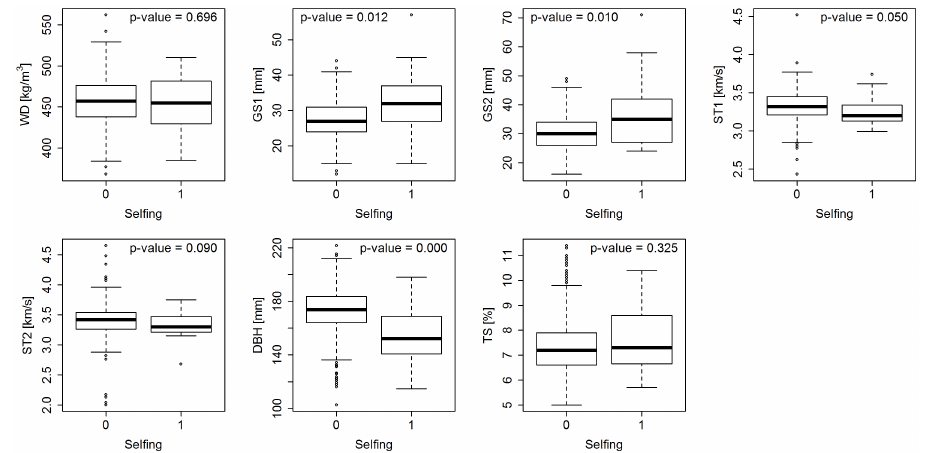
Fig 3. Inbreeding depression effect. Comparisonof performance betweenoutbred and inbredindividuals after sib-shipreconstruction and Welch t-test p-values; x-axis represents presence(1) or absence(0) of